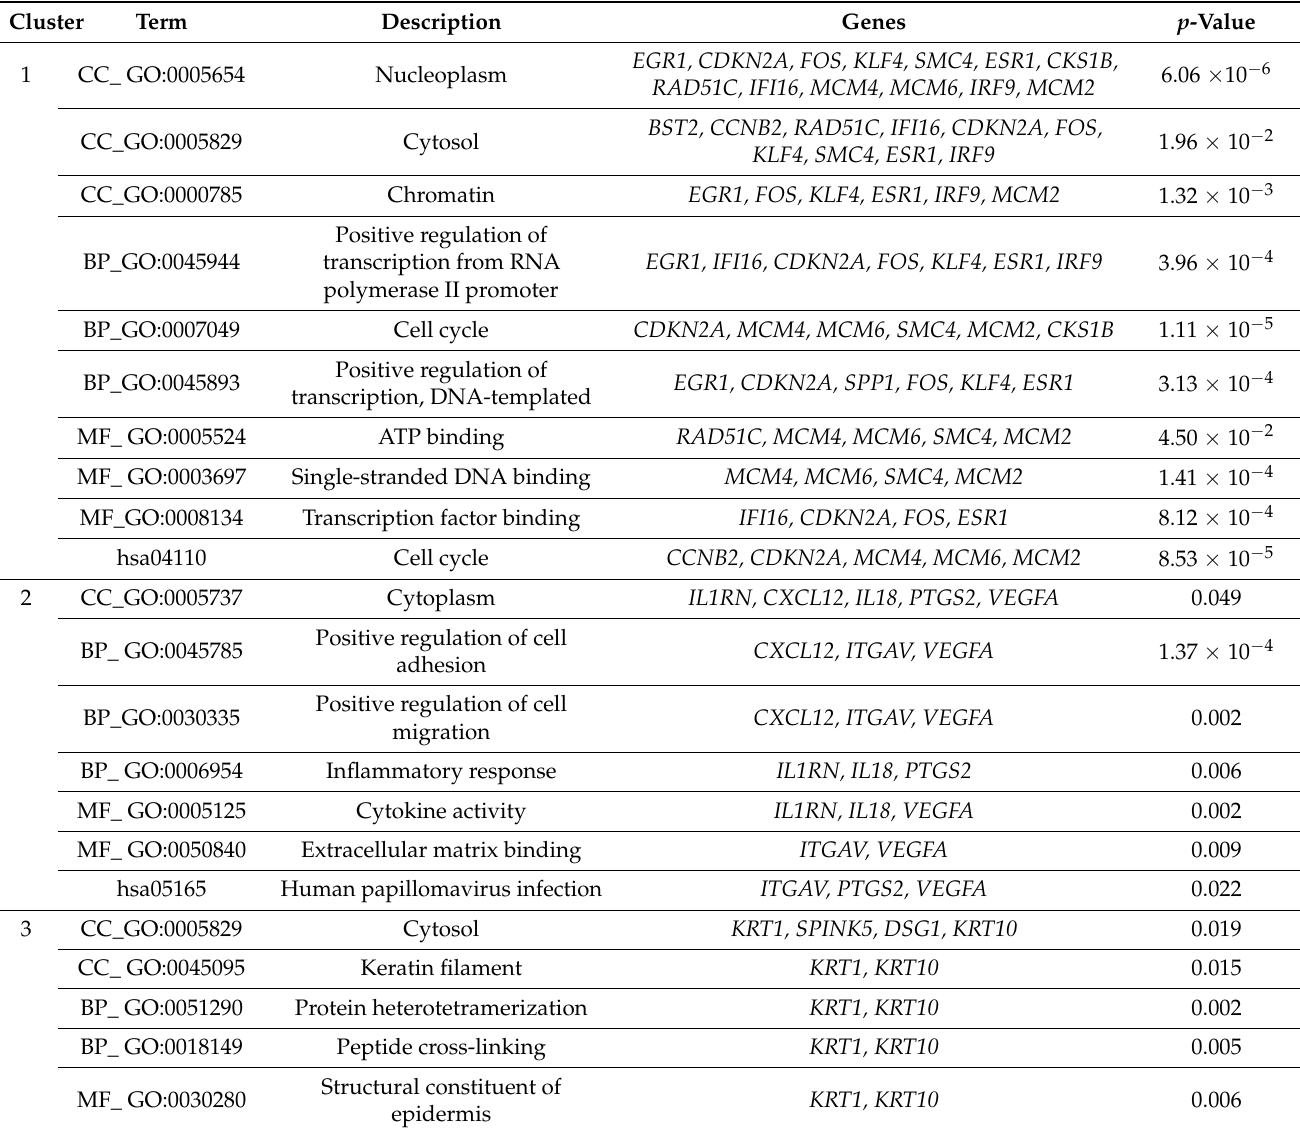
Table 2. Functional annotation clustering of the DEGs with highlighted candidate